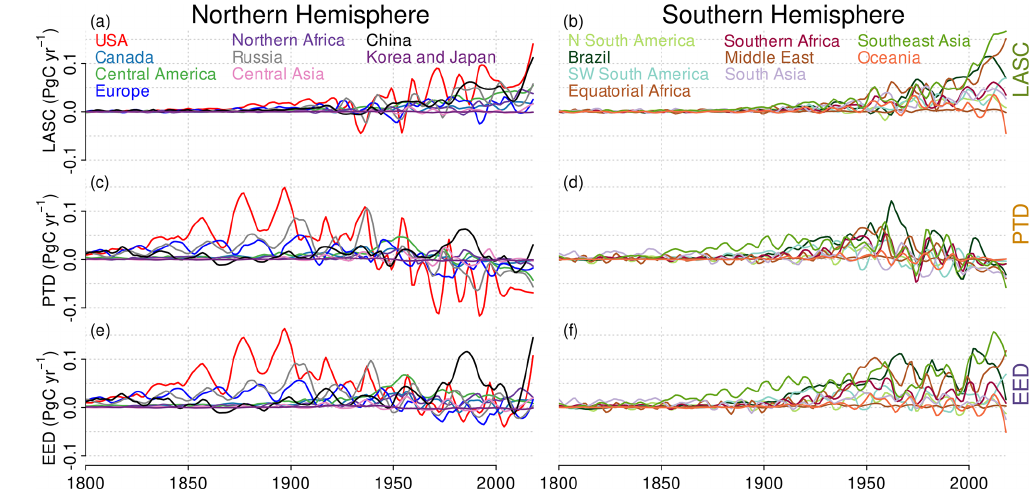
Figure 6. Region-wise smoothed multi-model mean annual loss of additional sink capacity (LASC; a, b ), difference between the f LULCC un- der present-day and pre-industrial environmental conditions (environmental equilibrium difference, EED; c, d ), and “present-day” vs. “tran- sient” environmental conditions difference in the f LULCC (PTD; e, f ) from 1800 to 2018, derived according to Eqs. (4) to (6). For discussion of individual models refer to Sect. A1 and Figs. A4 to A6 and Figs. A10 to A12. The PTD was not derived for CLM5.0, JULES, LPJ, and OCN (Table